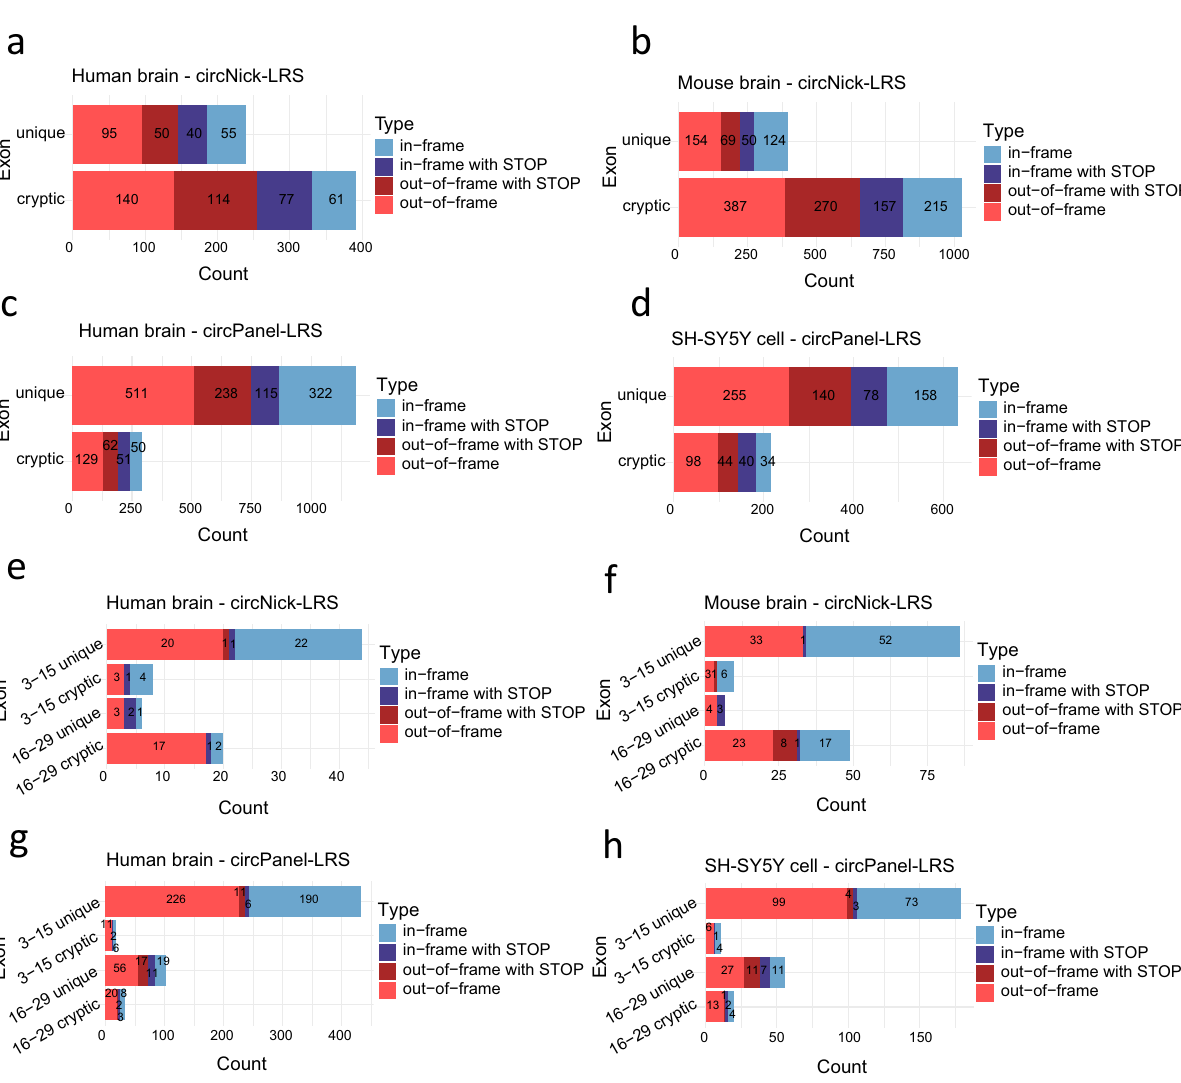
Fig. 6 Frequency of frameshifting and stop codons upon inclusion of unique and cryptic novel exons. a – d Exon frame barplots for all unique novel exons (upper bar) and cryptic novel exons (lower bar) in all four datasets. The type of frameshift caused by the circRNA-speci fi c exons are categorized as in- frame without stop codon (light blue), in frame with stop codon (dark blue), out of frame without stop codon (light red), and out of frame with stop codon (dark red). e – h Exon frame analysis for all novel microexons (categorized according to length) in all four datasets. All exons are covered by at least 5 long BSJ reads in